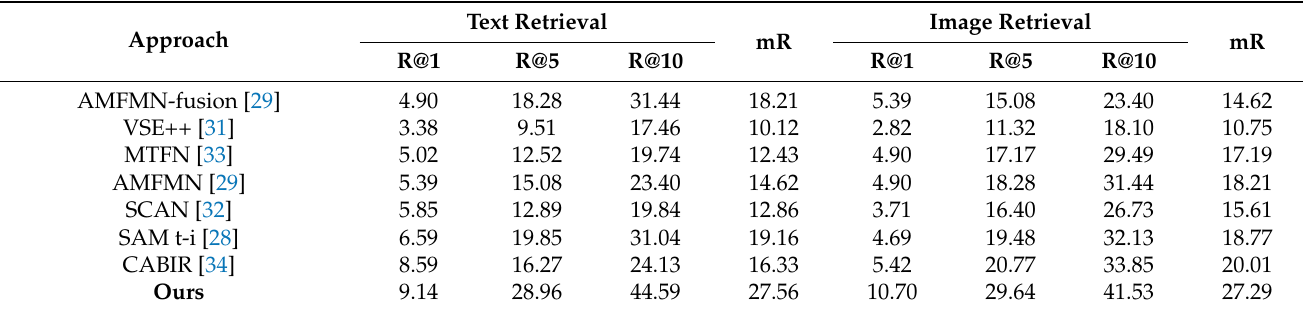
Table 8. Comparison between the state-of-the-art retrieval methods in the RSICD dataset in terms of